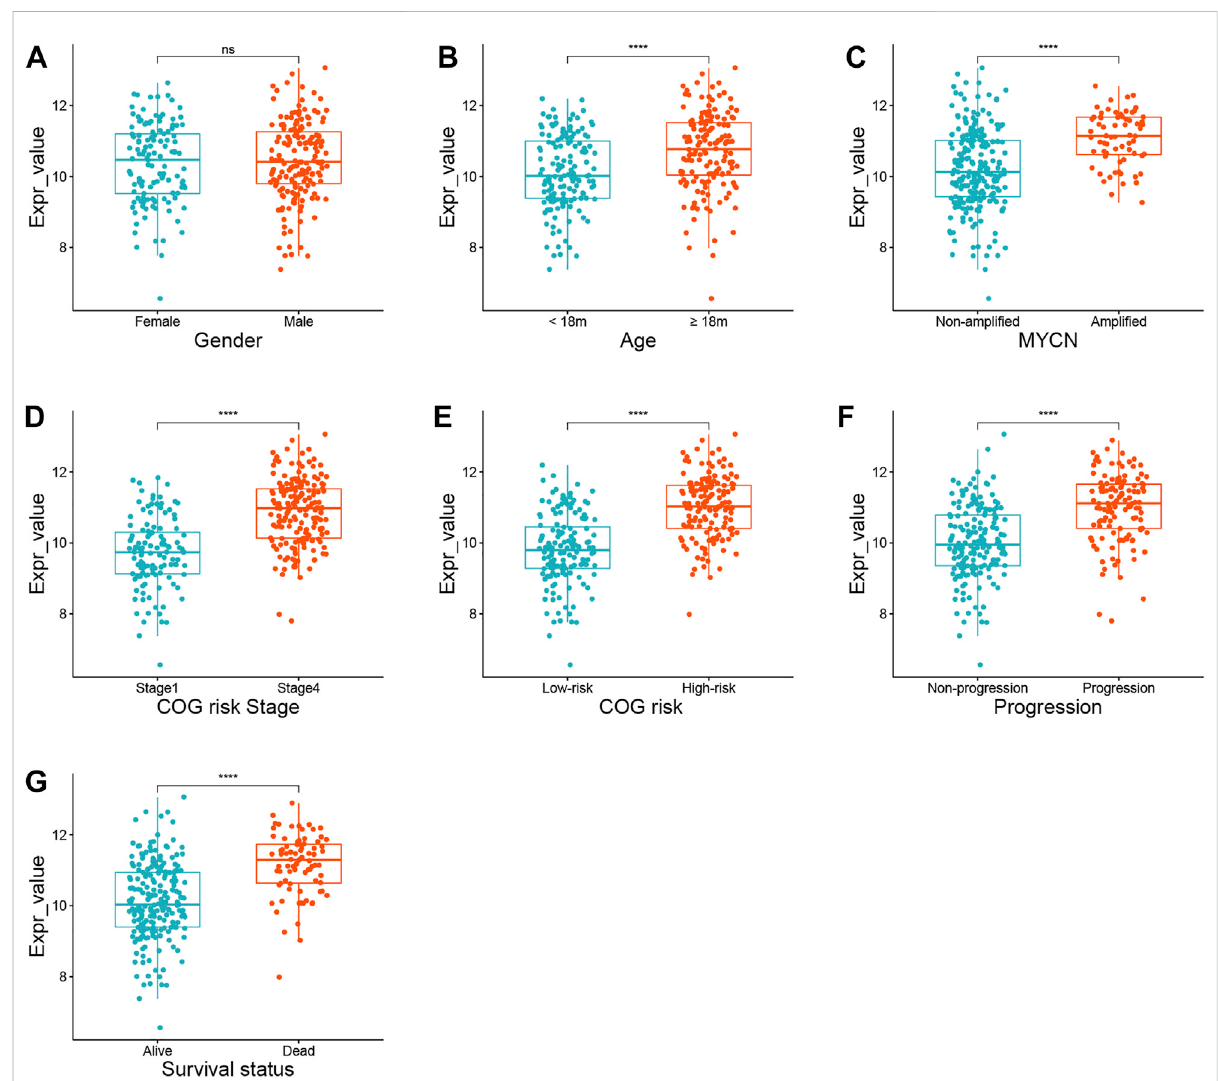
FIGURE 3 The expression status of AURKA in different subgroups. (A) Gender. (B) Age. (C) MYCN ampli fi cation status. (D) INSS stage. (E) COG risk status. (F) Progression. (G) Survival